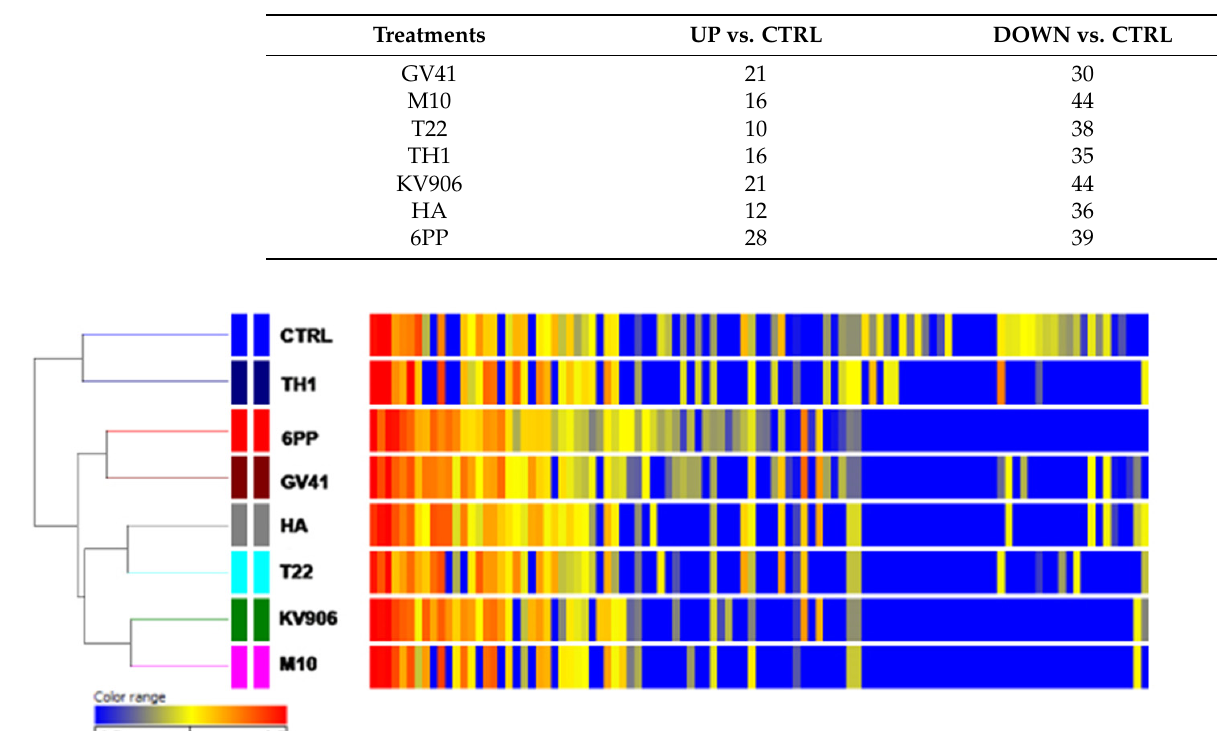
Figure 1. Hierarchical clustering heat map of differential metabolic profiles from olive drupe extracts. Samples are indicated by treatments with Trichoderma strains (TH1, GV41, T22, M10, and KV906) or secondary metabolites (HA and 6PP). Control was plants treated with water. Red color indicates higher phenolic abundance (>0), blue colors lower (<0), yellow a neutral change from the overall average abundance. Statistical significance was tested by one-way ANOVA ( p < 0.05).